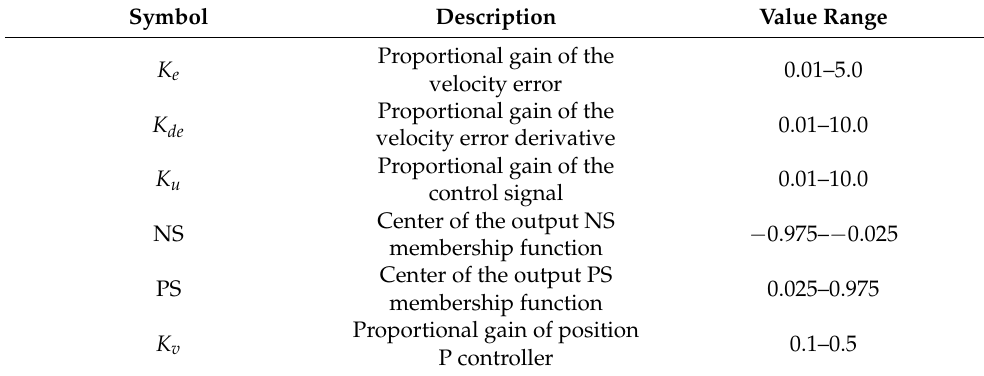
Table A2. Velocity FLCS parameters used in optimization design.